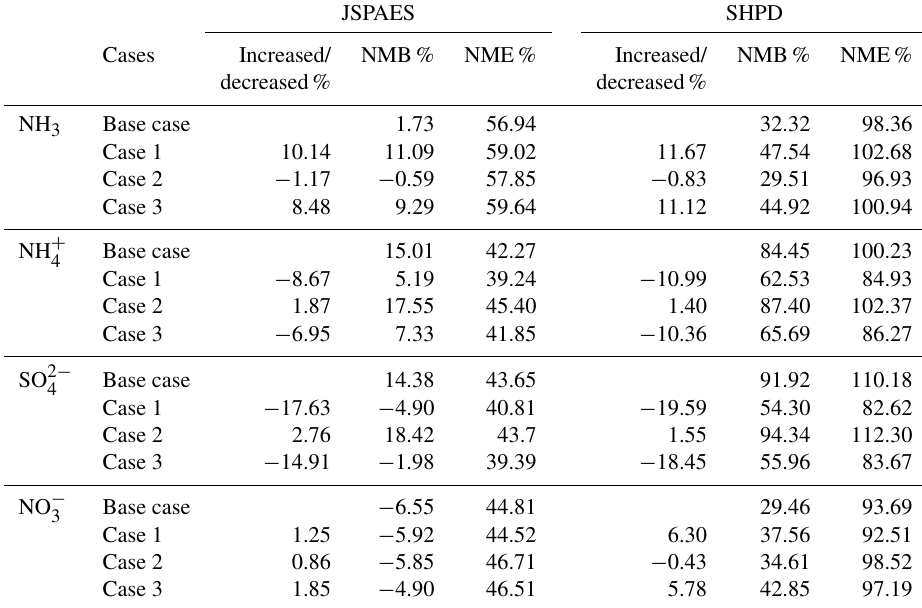
Table 6. The modeling performance at JSPAES and SHPD in cases with different SO 2 and NO x emission estimates. The NMBs and NMEs were based on the observed and simulated hourly